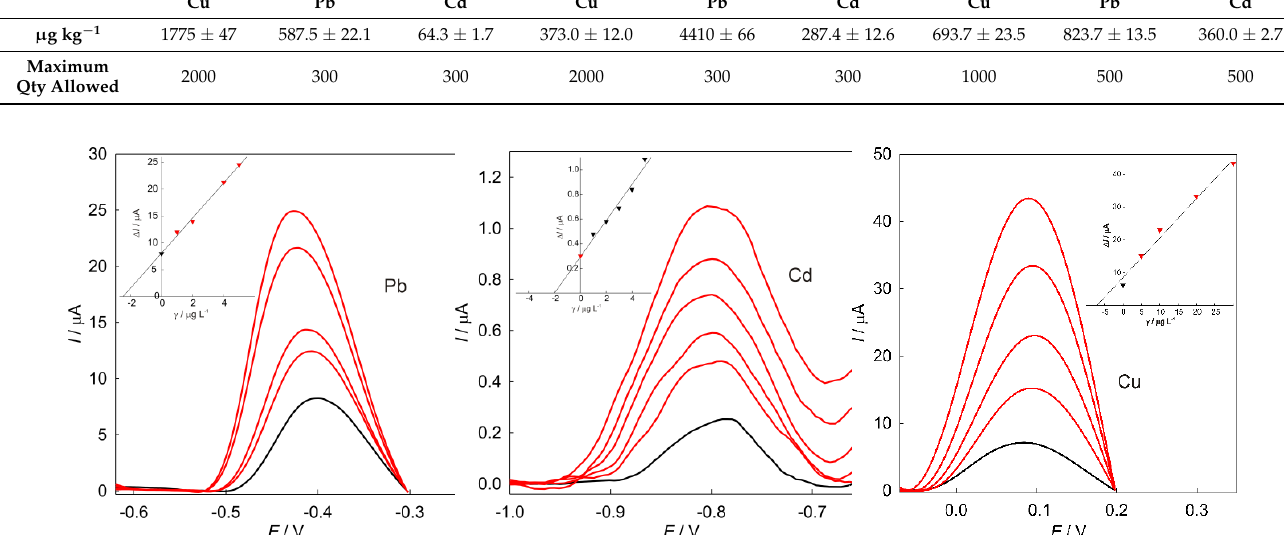
Figure 7. Examples of the SWCSVs of the prepared real sample (baseline corrected), recorded at the HAp/GC electrode in 0.2 M KNO 3 solution (pH = 4) together with the background response: lead in Honey 1, cadmium in Honey 2, and copper in sugar. The insets show the corresponding calibration plots.